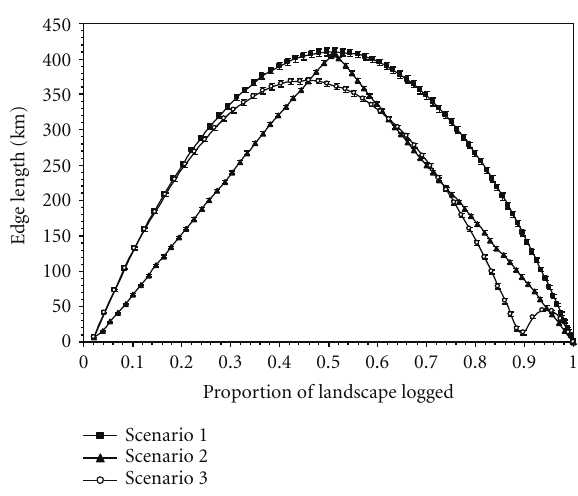
Figure 4: Edge length over 80 years of selective logging simulations in a forest landscape (4225 ha).